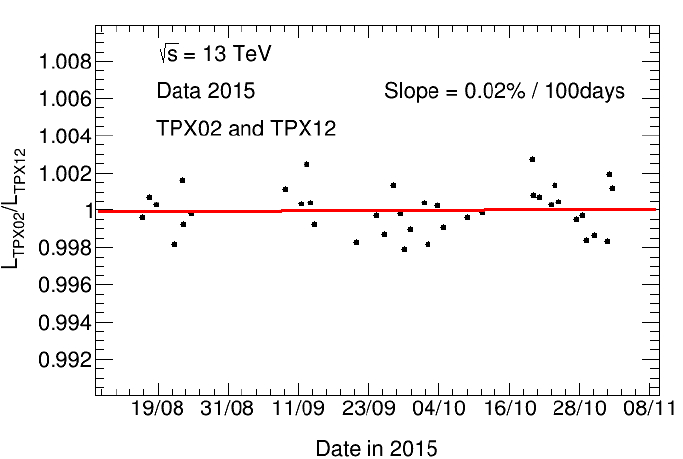
Figure 45. Time history of the luminosity ratio measured by the TPX02 and TPX12 devices averaged over the data taken by layers 1 and 2. The 2015 TPX data are divided into luminosity blocks of typically one minute length and then grouped into LHC fill time periods. The size of the statistical error bar is below the size of the data point. A linear fit is applied to determine the slope. LHC fills from August to November 2015. Taken from Ref.